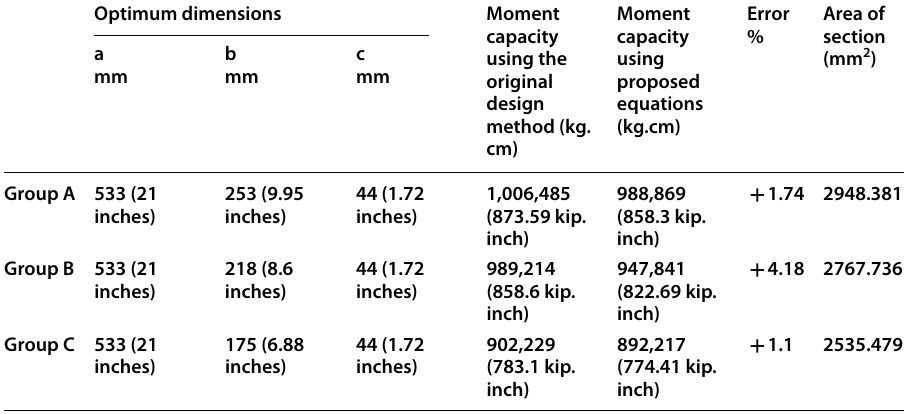
Table 4 Optimization results in the local buckling mode using proportions of groups A, B, and C